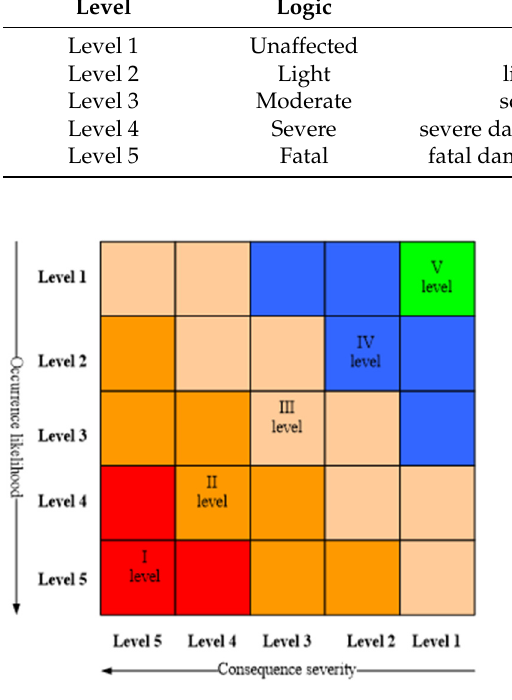
Figure 3. Configuration risks synthetically evaluation matrix.